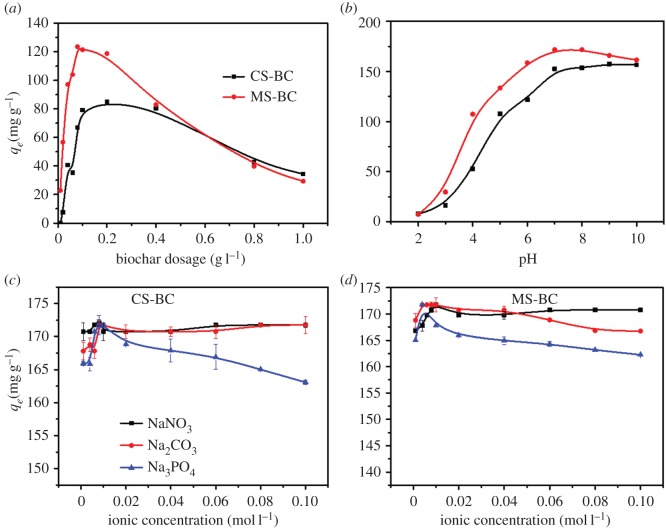
Effect of several parameters on the adsorption of Pb(II) on CS-BC and MS-BC: (a) biochar loading; (b) pH; (c) NaNO3, Na2CO3 and Na3PO4 concentrations for CS-BC and (d) NaNO3, Na2CO3 and Na3PO4 concentrations for MS-BC.